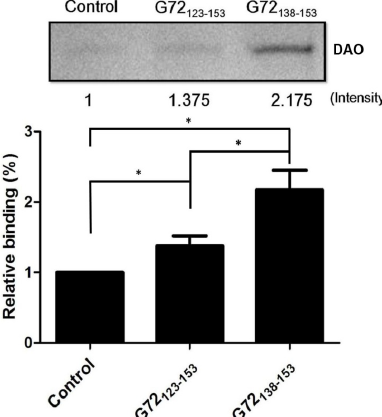
or 123–153 or G72 . After isolating 123–153 138–153